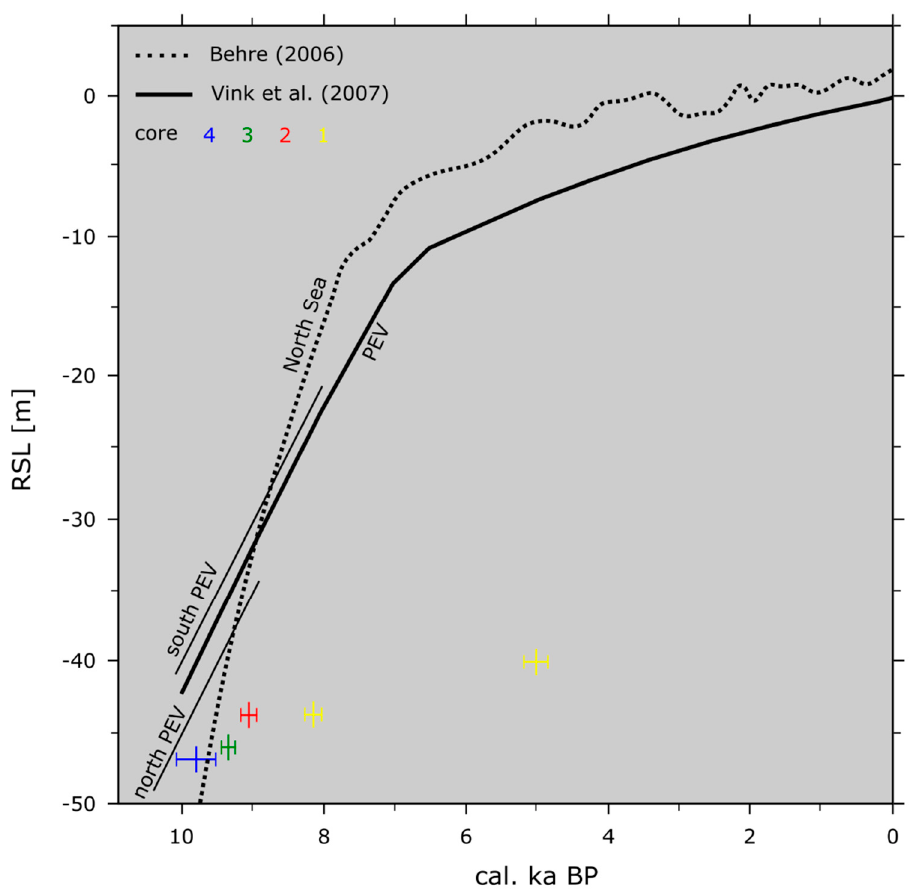
Figure 12. Relative sea-level curve for the southern North Sea modified after Behre [19] and Vink et al. [20] with determined AMS 14 C age.